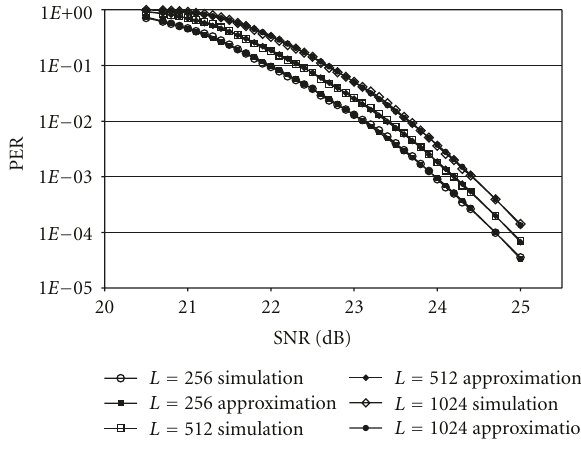
Figure 7: PER versus SNR.